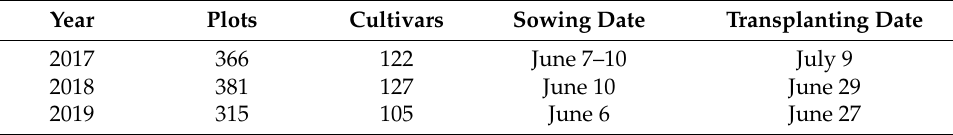
Table 1. Basic information of sowing and transplanting dates across rice cultivars.